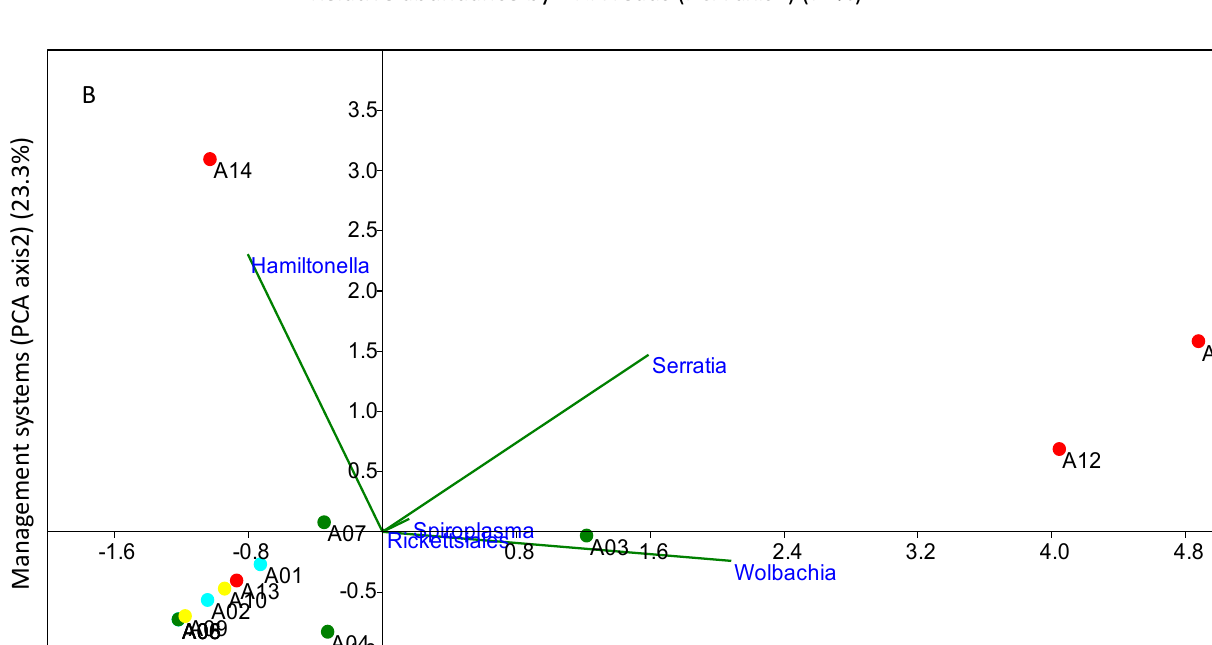
Figure 3. Principal components analyses (PCAs) using the proportion of variation in each PCA axis (bacterial DNA diversity as axis 1 and management as axis 2) explained by the most frequent obligate and facultative bacterial distribution ( A ) and only facultative bacterial distributions ( B ). The average count of each bacterial DNA reads numbers detected and log10 transformed from each sample grouping as response variables as component 1 (PCA axis1) and management systems as component 2 (PCA axis 2) scores were used.